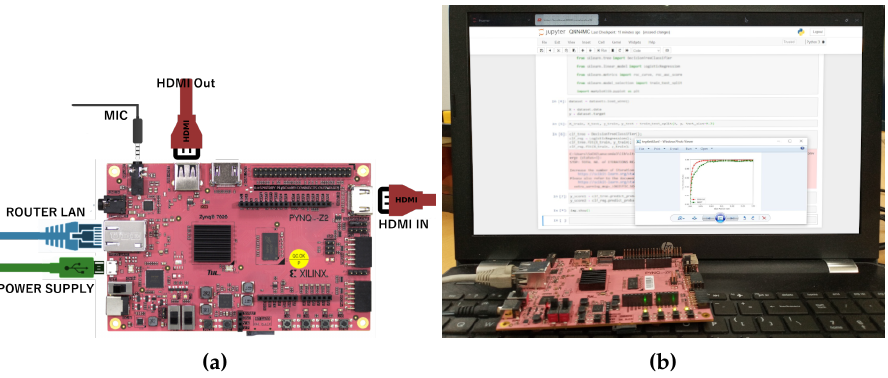
Figure 9. The PYNQ Z2 Xilinx board and its operational setup. ( a ) FPGA Xilinx 7200 Pynq Z2 board; ( b ) setup with the RoC curve for the CIFAR-10 and MNIST for